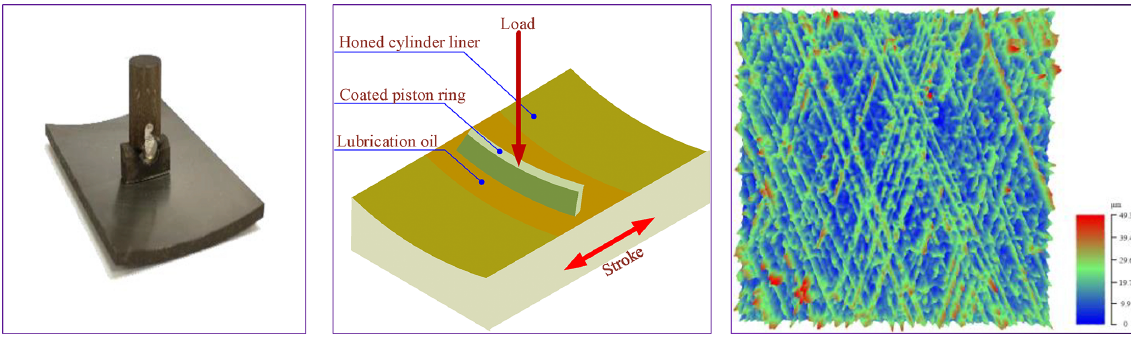
Figure 3. A schematic diagram of the testing process.